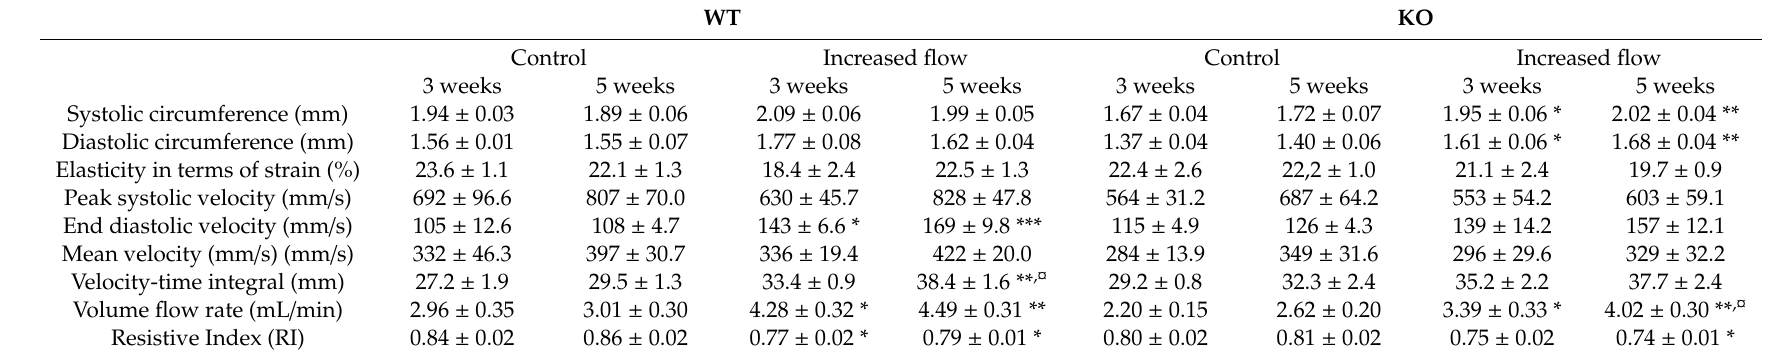
Table 1. Ultrasound biomicroscopy assessment of vascular remodeling in the right CCA following left carotid